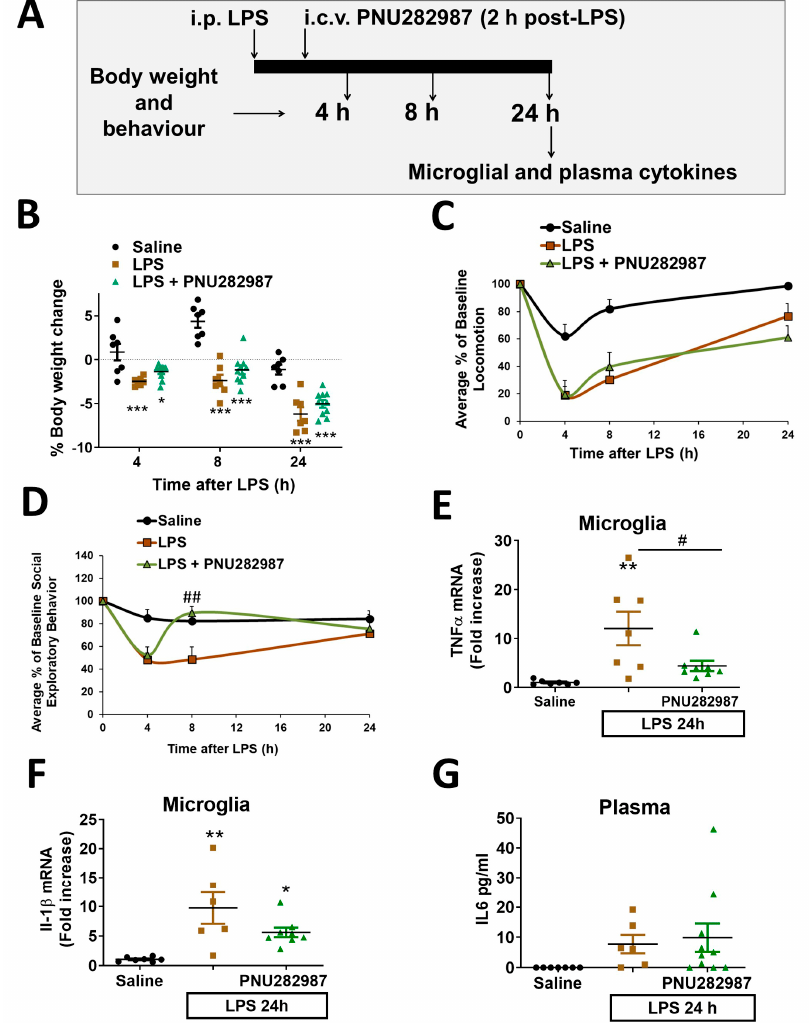
Figure 3. Central activation of α 7 nAChRs attenuates sickness behavior and neuroinflammation elicited by LPS challenge in adult mice when administered 2h post-LPS. ( A ) Experimental protocol used in adult Balb/c mice injected i.p. with LPS 0.33 mg/kg ± i.c.v. PNU282987 (10 µg) 2 h post-LPS. ( B ) Body weight change, ( C ) locomotor activity and ( D ) social exploratory behavior; measured 4, 8 and 24 h after saline/LPS injection. ( E ) Plasma IL-6 levels after saline/LPS injections. Microglial mRNA levels of IL-1 β ( F ) and TNF α ( G ) 24 h after saline/LPS injections. Data correspond to the mean and S.E.M of 6–8 animals per group. Comparisons were made using one-way ANOVA ( E – G ) and two-ways ANOVA ( B – D ). * p < 0.05, ** p < 0.01, *** p < 0.001 vs. saline; # p < 0.05, ## p < 0.01 LPS.